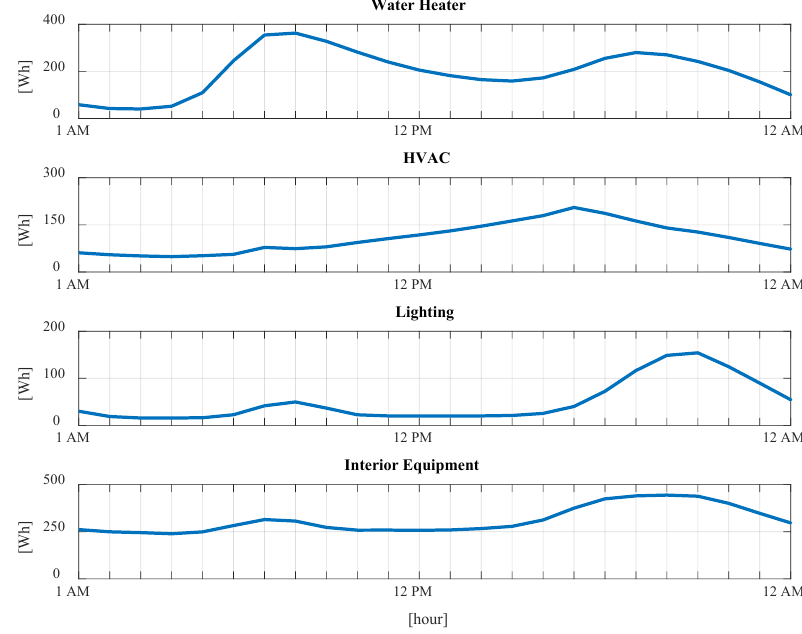
Figure 11. Battery SoC and PV-load power during a five-day period: ( a ) in April, ( b ) in October.